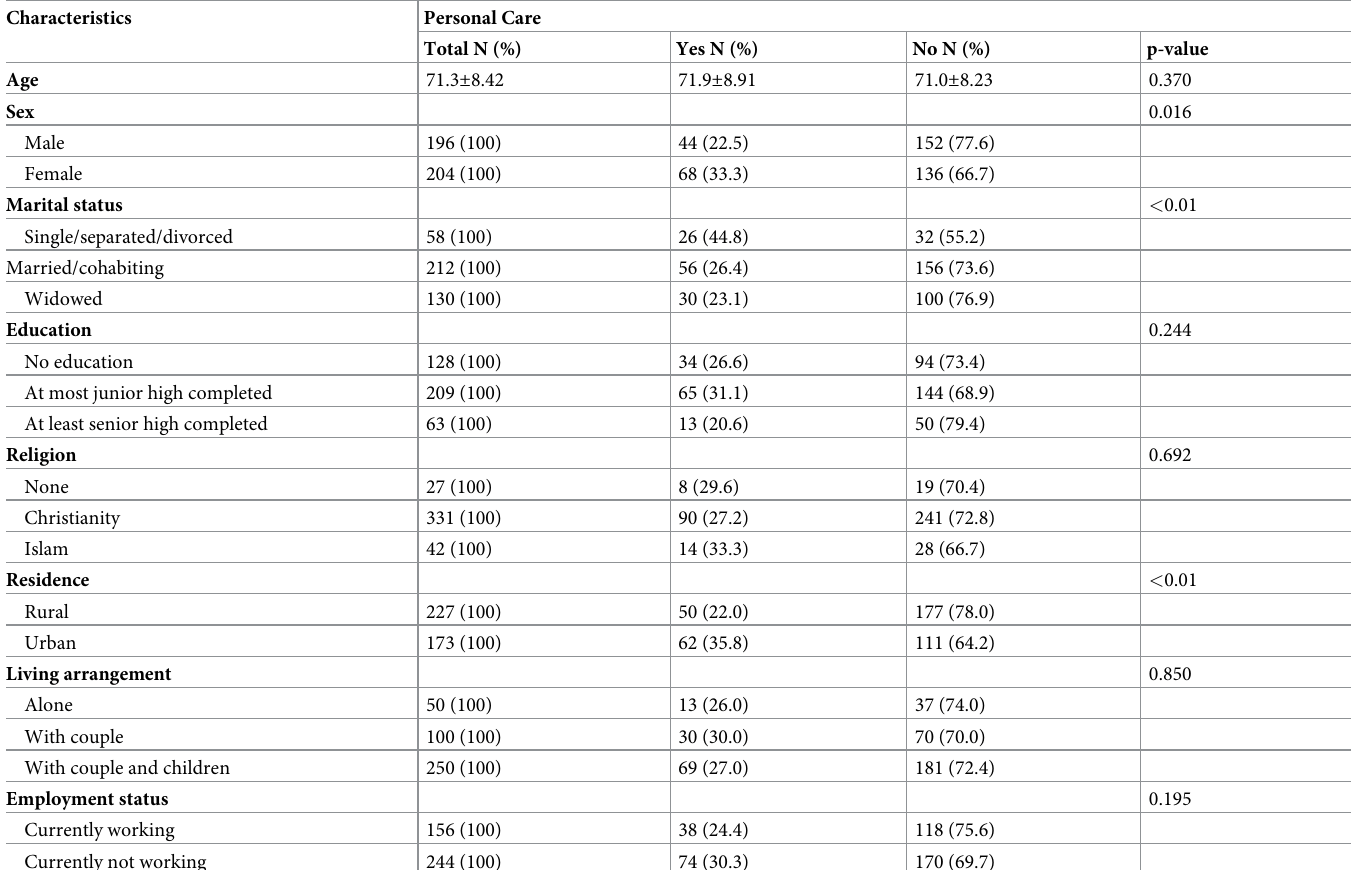
Table 2. Univariate analysis of older adult inpatients who provide personal care. Characteristics